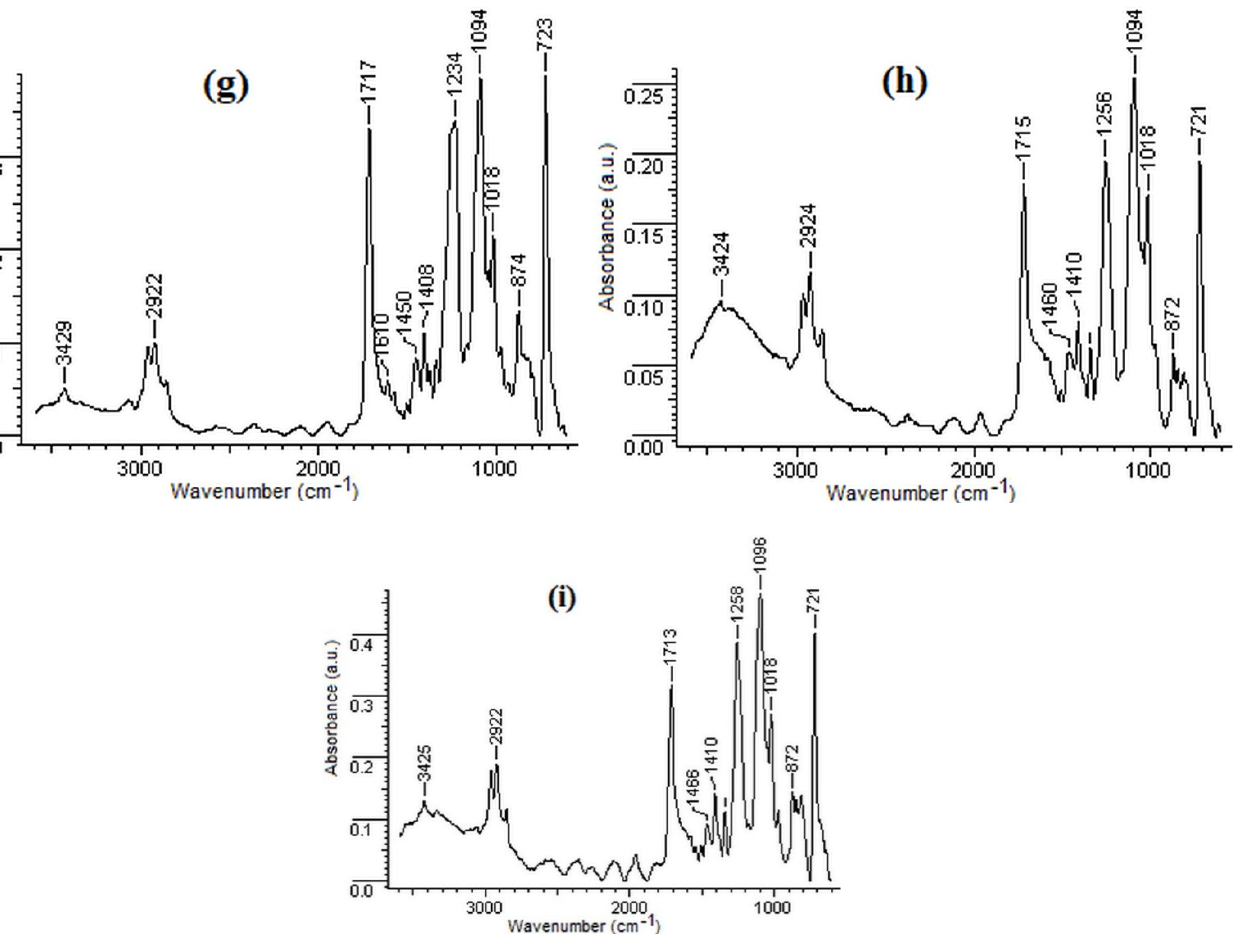
Figure 10. FTIR spectra of ( a ) 100H; ( b ) 75H25PP; ( c ) 50H50PP; ( d ) 25H75PP; ( e ) 100PP; ( f ) 50H50BI; ( g ) 100BI; ( h ) 50H50PES and ( i ) 100PES.